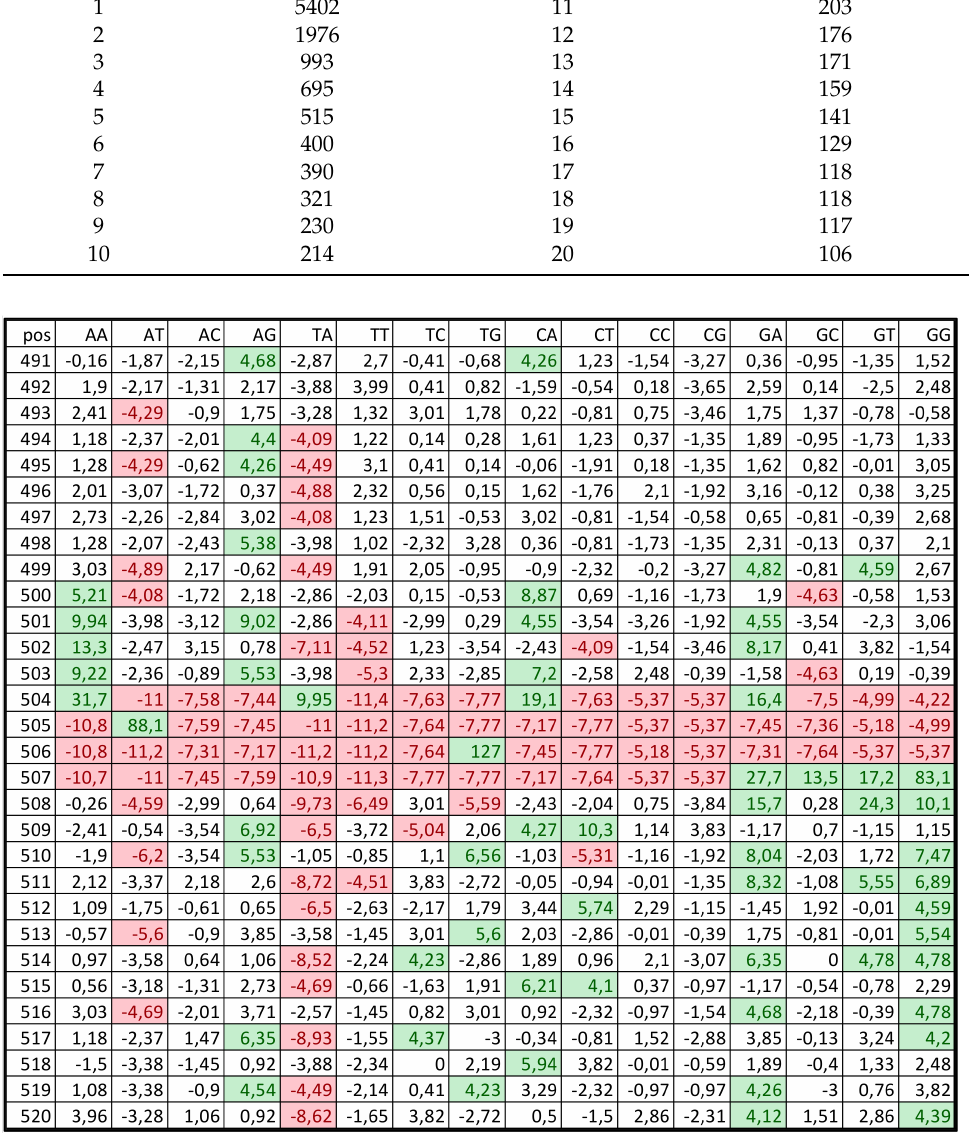
Figure 1. Part of the PWM’ for the first C. annuum promoter class. Elements with values < − 4 and >4 are highlighted red and green,